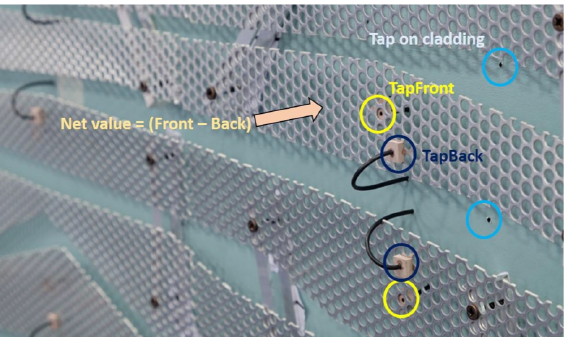
Figure 4. Pressure taps on the model surface: detail on the set up for measurement of the differential pressure on the porous layer.